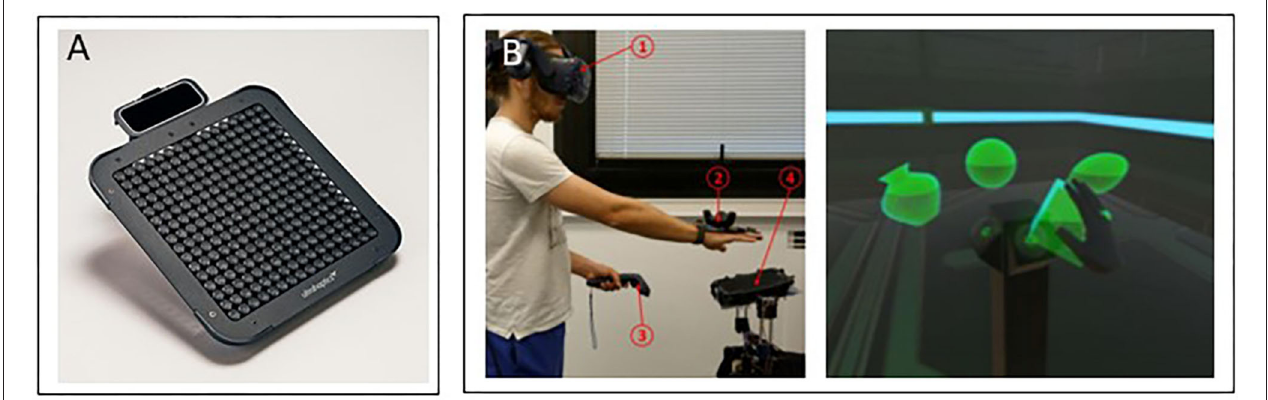
FIGURE 4 | Mid-air devices. (A) The Ultraleap device (https://www.ultraleap.com/). (B) Its application to interaction with a virtual reality environment (Howard et al.,